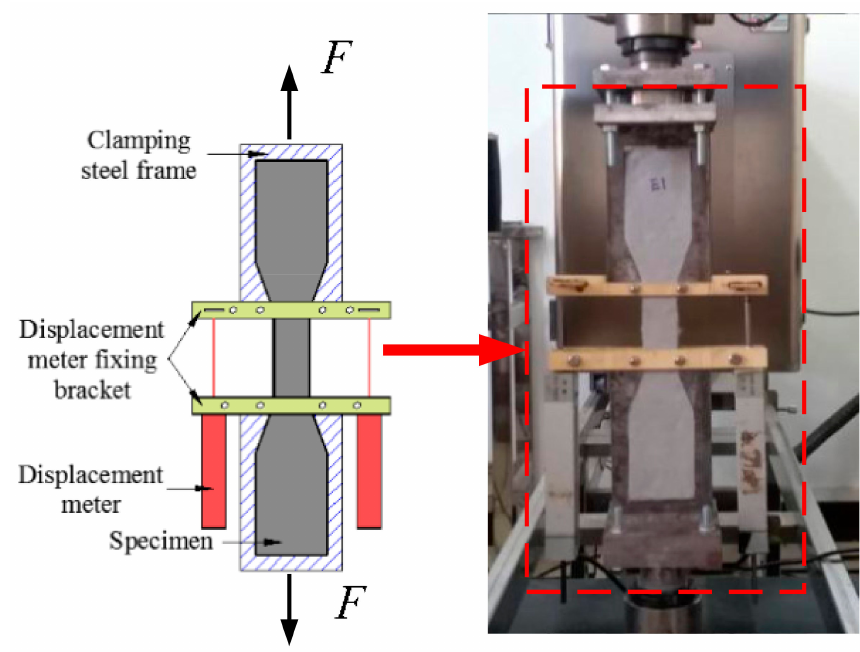
Figure 3. Schematic diagram of specimen loading